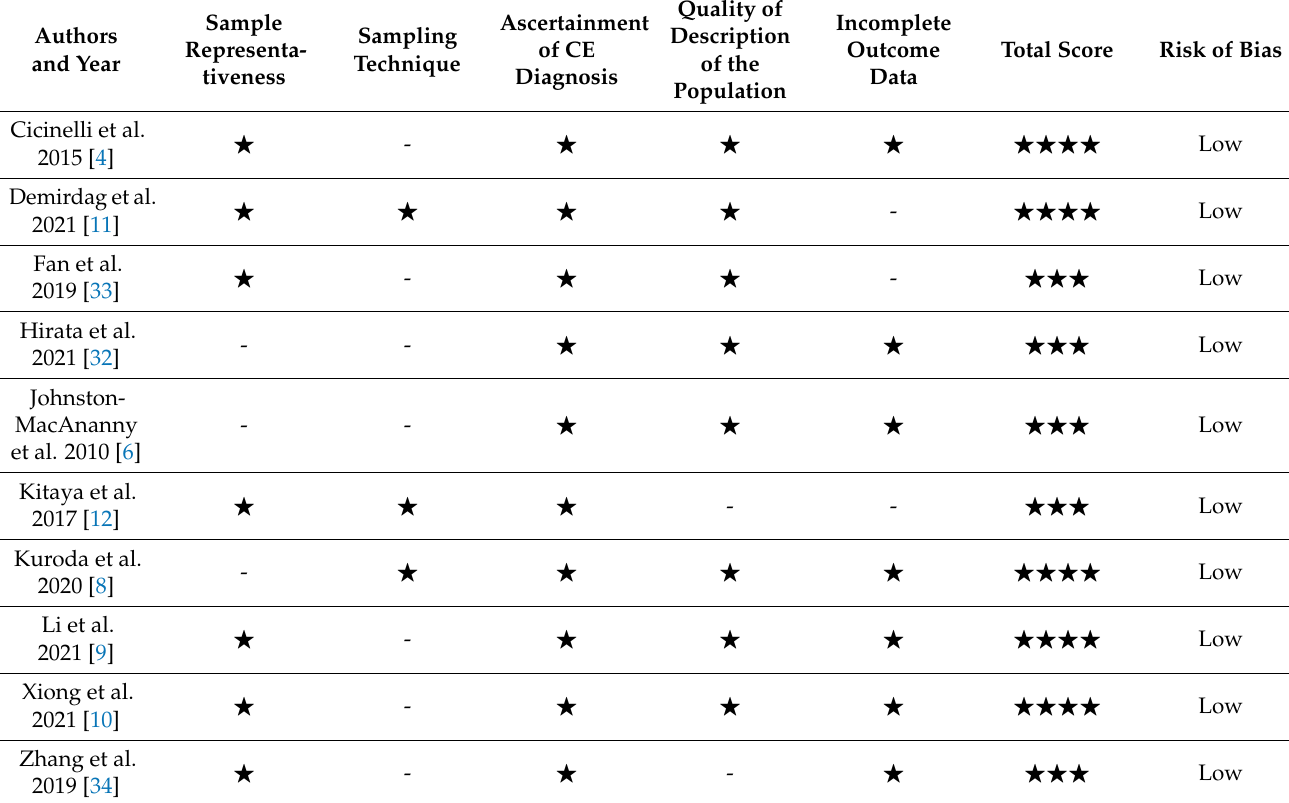
Table 1. Risk of bias